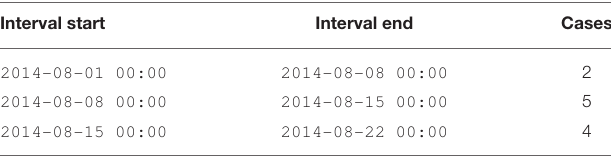
TABLE 4 | Explicit transformation of Table 1 into a trailing inclusive interval series. Interval start